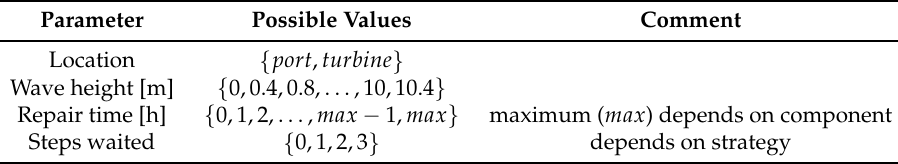
Table 1. The different parameters of the states and their possible values.